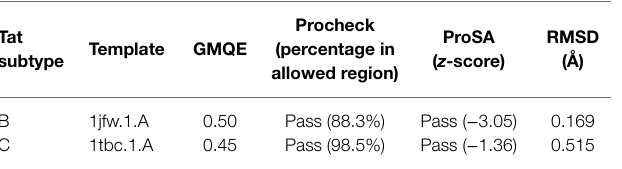
TABLE 1 | Summary of the quality assessment scores for the 3D predicted structures of Tat subtype B and